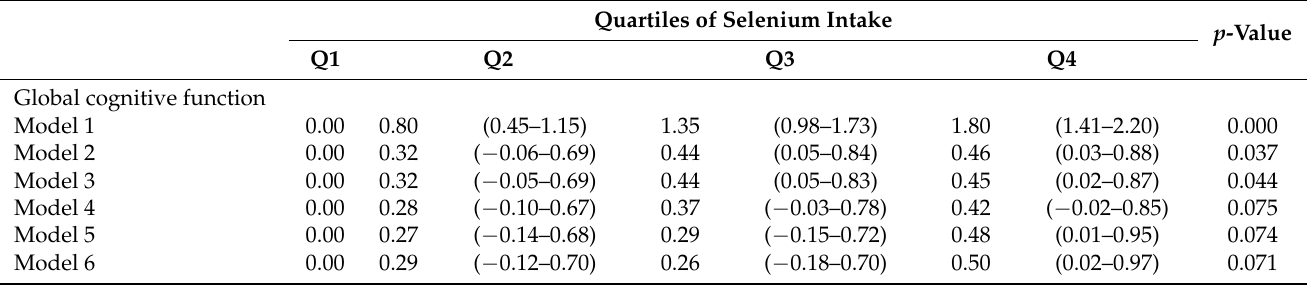
Table 2. Association between quartiles of selenium intake and cognitive function among Chinese adults aged 55 years and above attending the China Health and Nutrition Survey ( n =